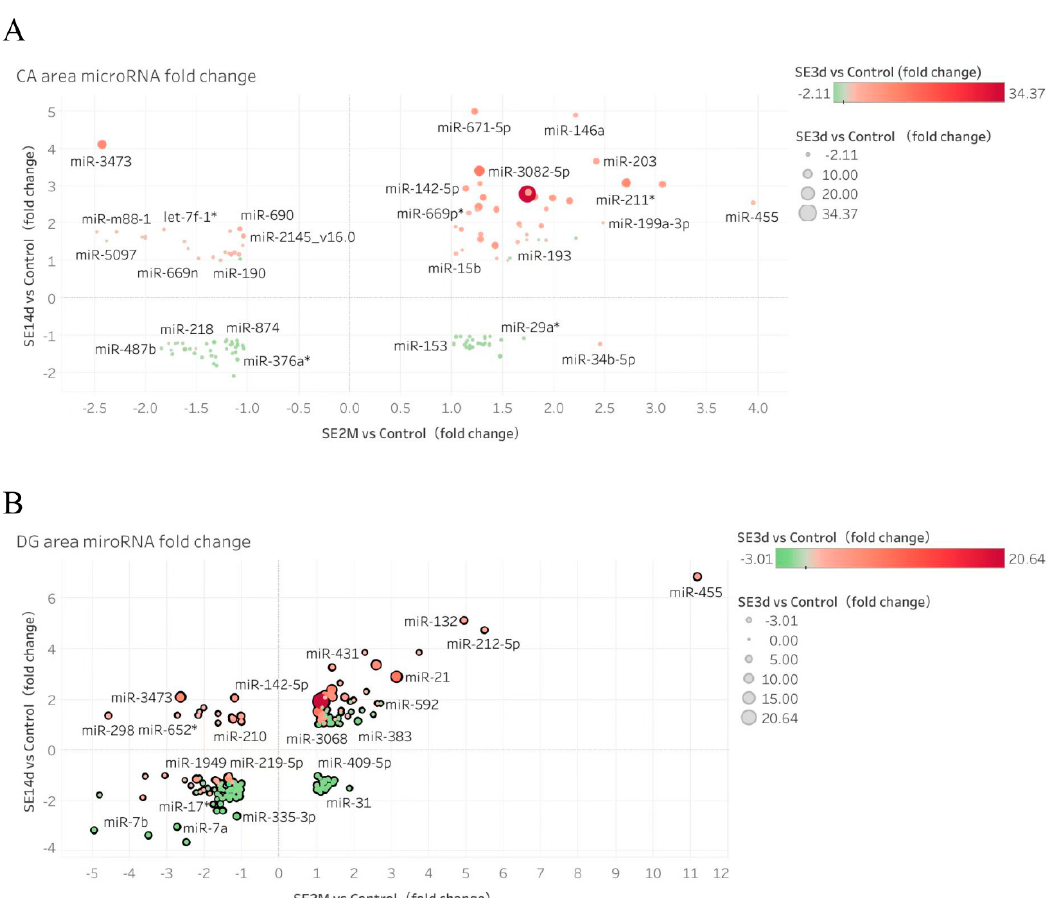
Figure 1. Differently expressed miRNAs in the CA ( A ) and DG ( B ) areas over three time points. The fold-change value on day 14 post-SE was used as the ordinate and the fold-change value on day 60 post-SE as the abscissa. The colour gradient (from green to red) and the size of dots were used to represent the fold-change value on day 3 post-SE. miR-494 and 188-5p were excluded according to the validation results. Tableau software was used to map the changes in the expression of different miRNAs. Note: the * in the figure like miR-29a* has no other meaning but the name of a specific miRNA. Table 1. Validation of microarray results in the CA area by